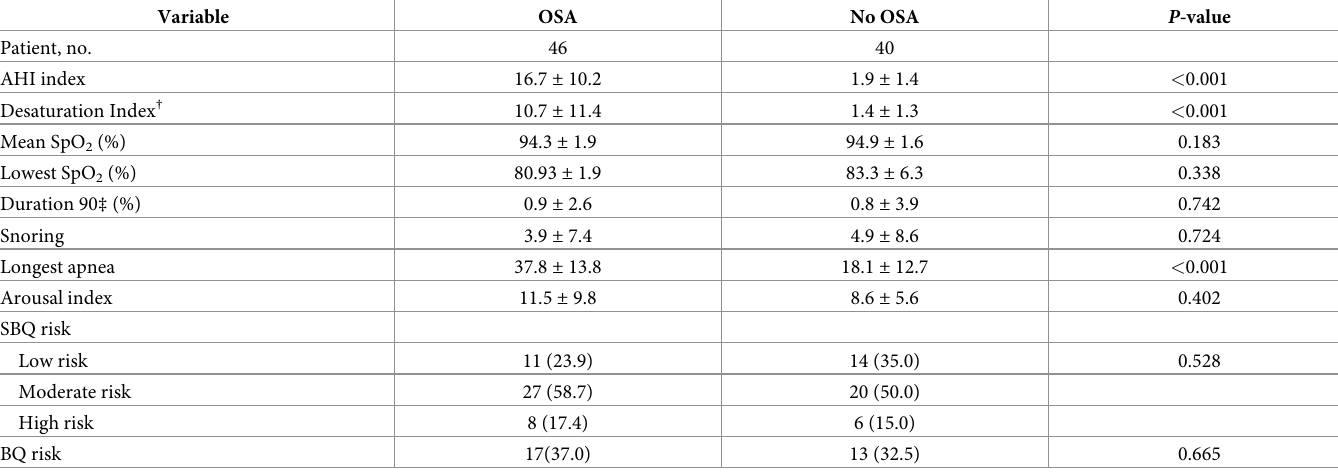
Table 2. Comparison of sleep data and questionnaire between OSA and no OSA